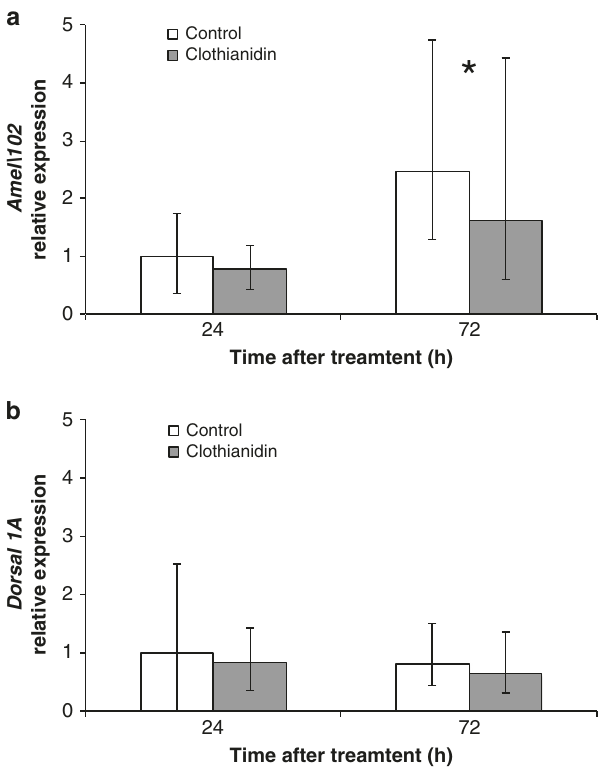
Fig. 2 Relative expression over time of two genes involved in humoral and cellular immune response of honey bee larvae. At each time point, 15 biologically independent larvae per treatment were sampled. The asterisk denotes a signi fi cant difference (Mann – Whitney U test: n 1 = 15, n 2 = 15, U = 58, one tailed P = 0.012) for the mean values recorded at a speci fi c time point; error bars represent the standard deviation of the mean, calculated according to the ΔΔ Ct method. a Relative expression over time of Amel\102 . b Relative expression over time of Dorsal 1A . titer after 24 h exposure to Clothianidin (Mann – Whitney U test: n 1 = 28, n 2 = 27, U = 140, P < 0.001; Fig. 3a). However, it is